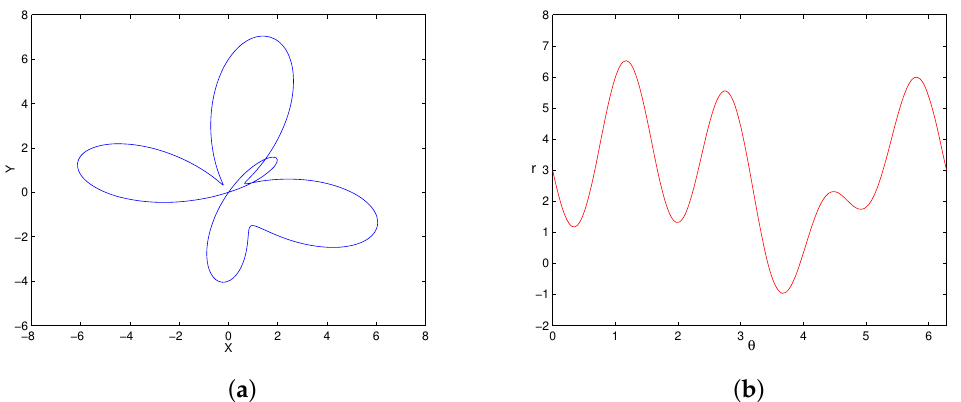
Figure 5. Estimation results without considering the constraint. ( a ) Estimated shape. ( b ) Approxima- tion of the radial function.